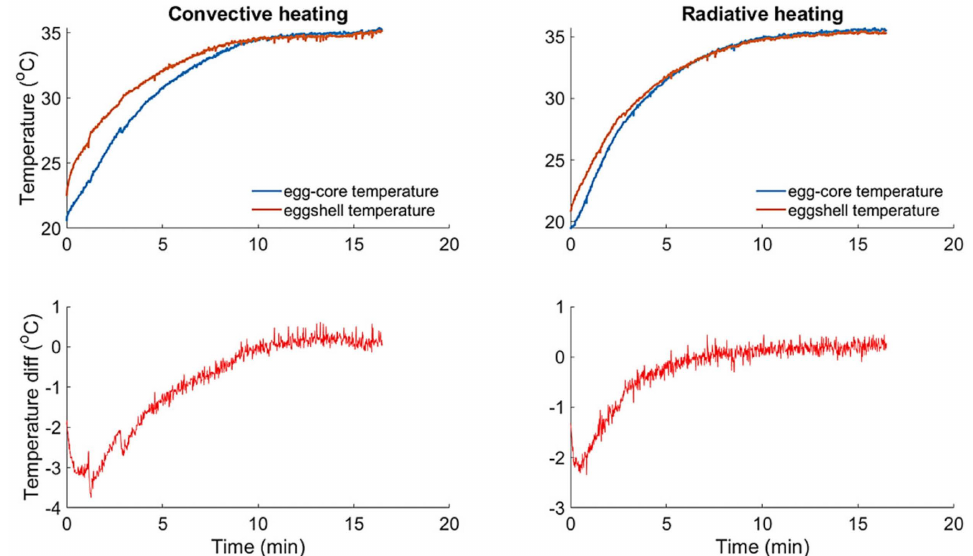
Figure 8. Step responses of eggshell and egg core temperatures to step up increases in convective-heating (left graphs) and radiative-heating (right graphs), with PWM = 10%, inside the experimental incubator. The ‘temperature di ff ’ is the di ff erence between the egg-core and the eggshell